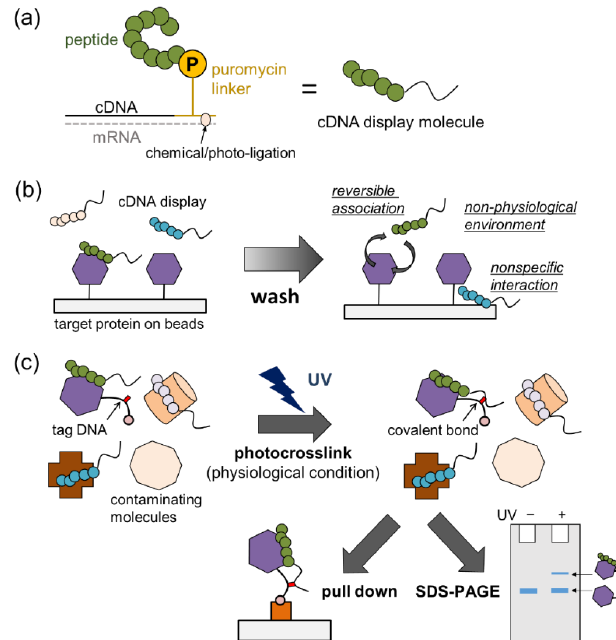
Figure 1. Photocrosslinking between complementary DNA (cDNA) display molecules and target proteins. ( a ) Schematic representation of a cDNA display molecule, where P indicates puromycin. ( b )